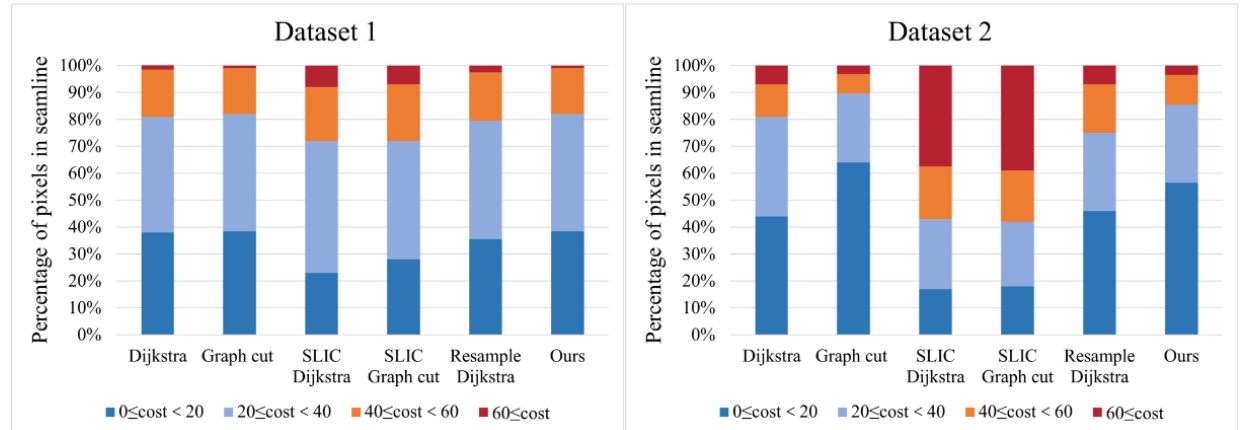
Figure 12. Refinement comparison of the cost (color difference) intervals on both sides of the seamline for the six methods of Dataset 1 and Dataset 2. The bar chart shows the percentage of seamline pixels in each interval.